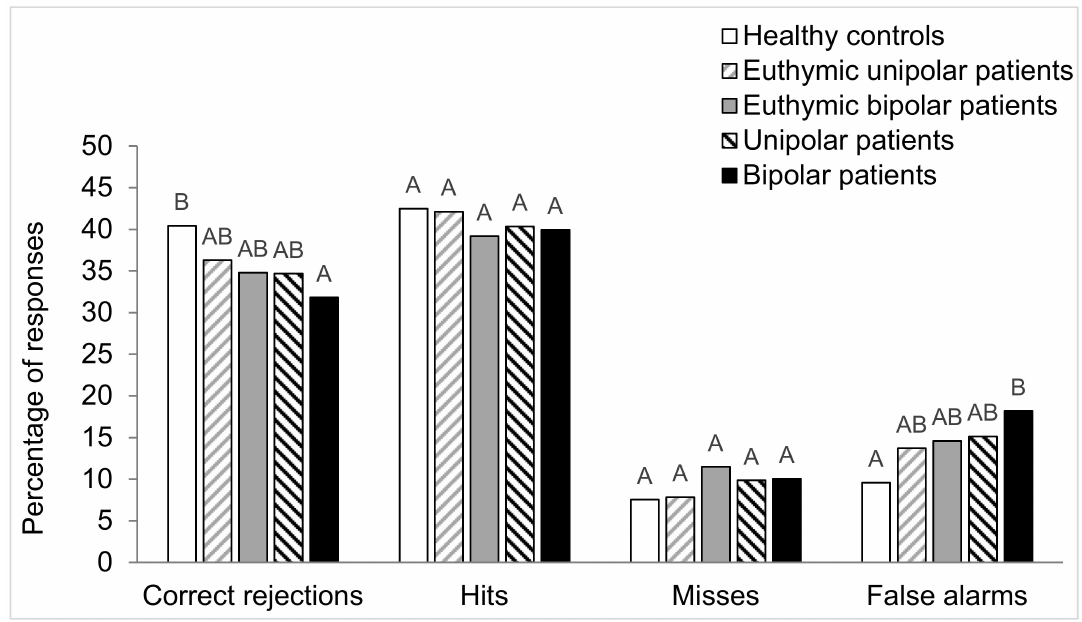
Figure 4. Between-groups comparison of the percentage of correct rejections, hits, misses, and false alarms responses. For each type of responses, values with the same letters are not significantly di ff erent at the 5% level of significance (Marascuilo